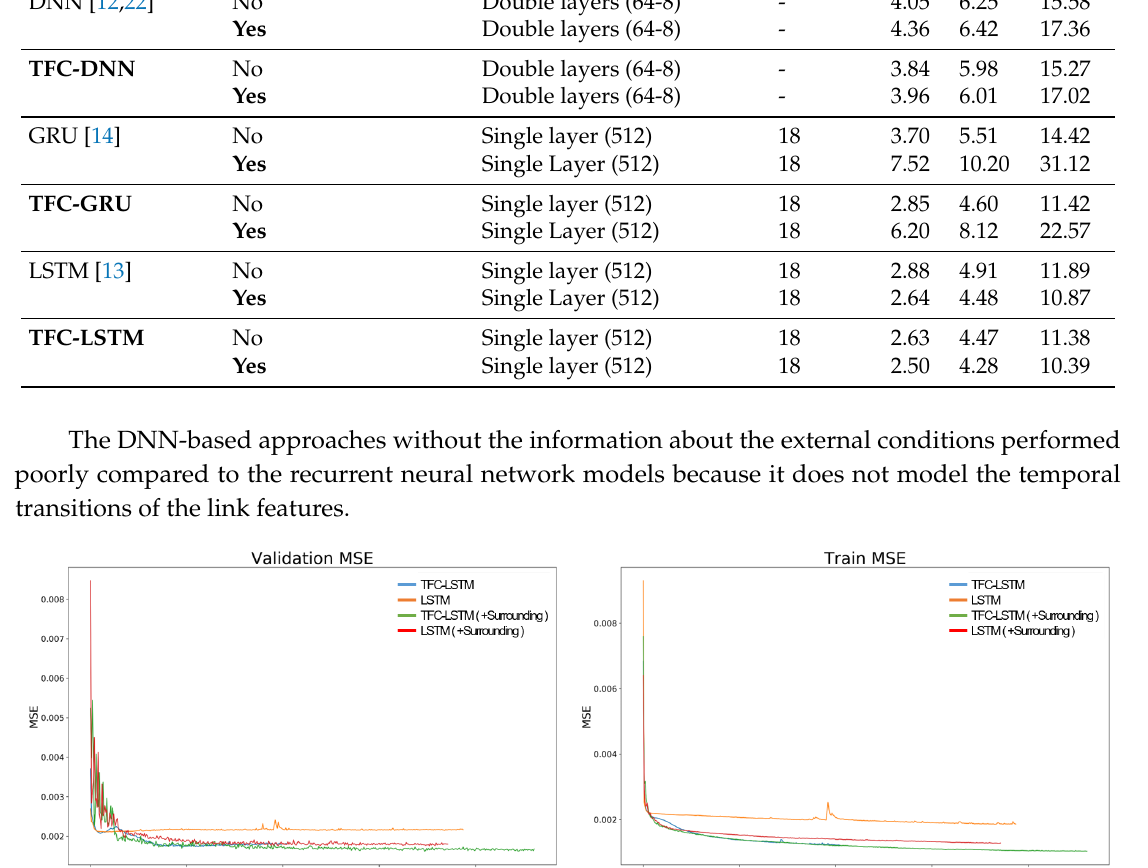
Table 4. Comparison of prediction performance. Usage of Surrounding Hidden Layer Structure Prediction Models